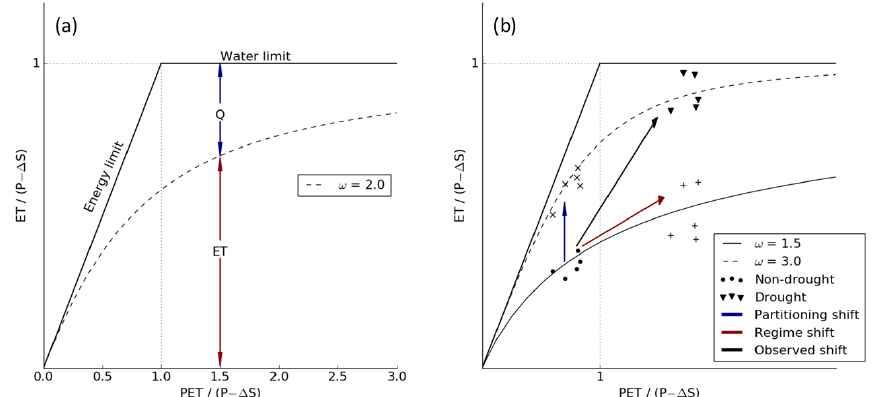
Figure 2. (a) Conceptual plot of the extended Budyko framework, illustrating how the calibrated Fu equation dictates partitioning of available water and (b) conceptual illustration of drought-induced water balance shifts. ET is evapotranspiration, P is precipitation, (cid:49)S is change in plant-accessible soil storage, and Q is